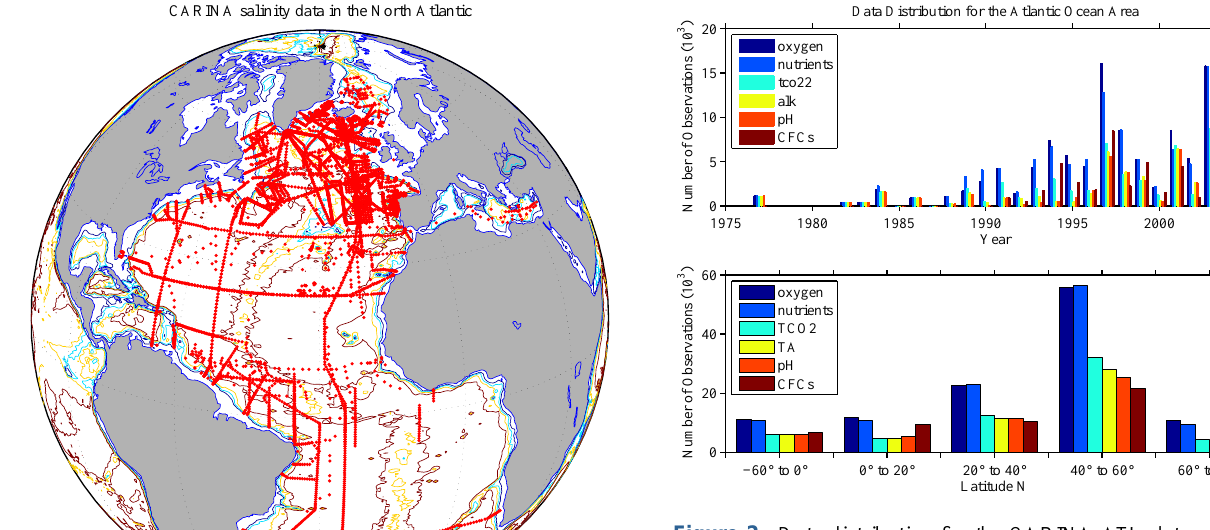
Figure 2. Data distribution for the CARINA-ATL data set. Top panel: Number of measurements during individual years, year markers in the centre of each group of observations. Lower panel: Distribution of measurements over latitudinal bands. Note that this plot includes interpolated data and calculated carbon